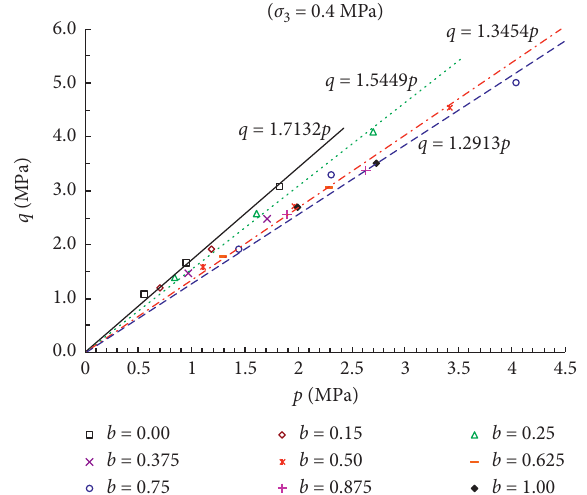
Figure 11: Comparison on the constant σ the plane strain test ( σ 3 � 0.4